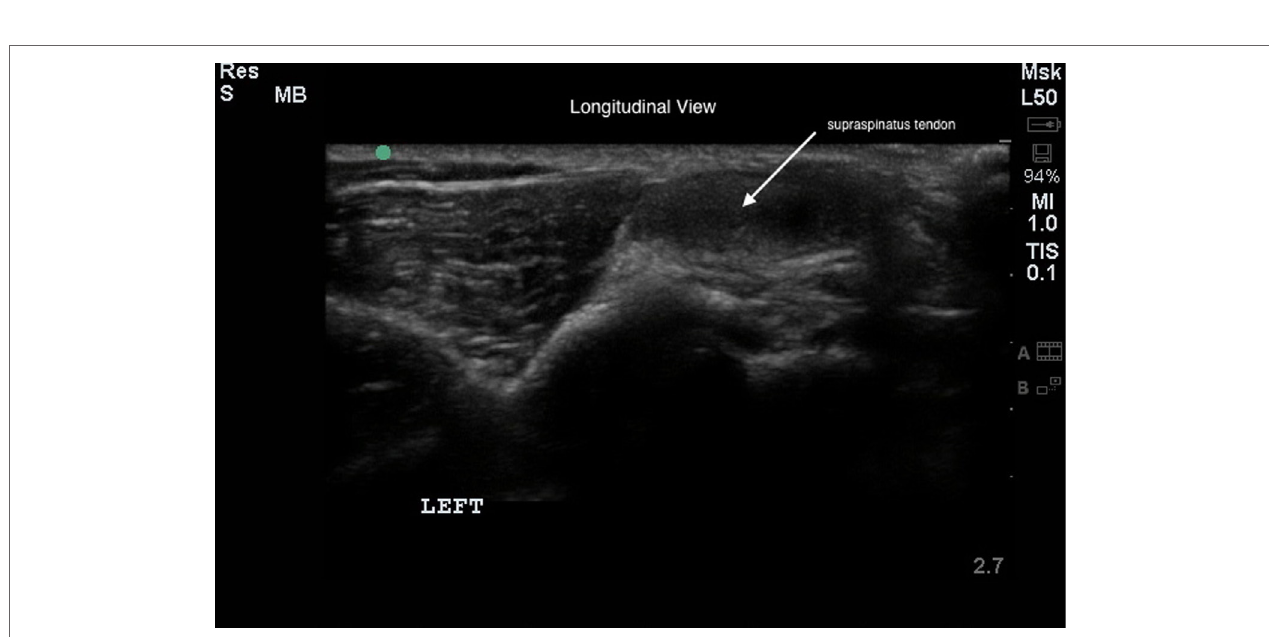
FigUre 1 | The transverse diagnostic musculoskeletal ultrasound image of the supraspinatus tendon (white outline)